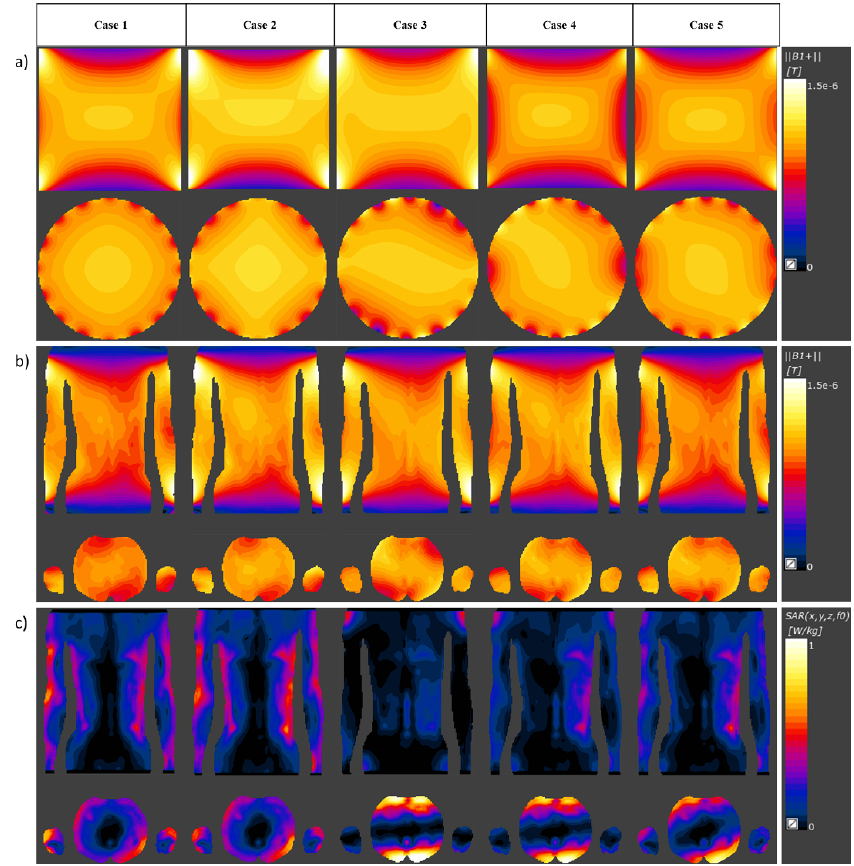
Figure 3. ( a ) Respective B 1+ ‐ field distribution in cylindrical uniform phantom (top–coronal; bottom– axial); ( b ) respective B 1+ ‐ field distribution in 3D human “Duke” model (top–coronal; bottom–axial); ( c ) respective SAR distribution in human “Duke” model (top–coronal; bottom–axial). Note that input powers for B 1+ ‐ field and SAR distributions were normalized to 1 μ T. Table 2. Summary of uniformity, input power, transmit efficiency, and maximum B 1+ at 20 kW (most commercial MRI systems are equipped with 20 kW RF amplifier) in cylindrical uniform phantom; mean 10 g average SAR and peak 10 g average SAR in human “Duke” model for simulated RF coils in optimal driving mode, as shown in Figure 1. Case 1